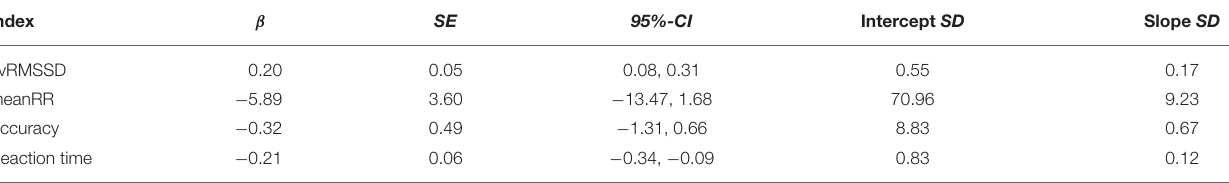
TABLE 3 | LME outcome.